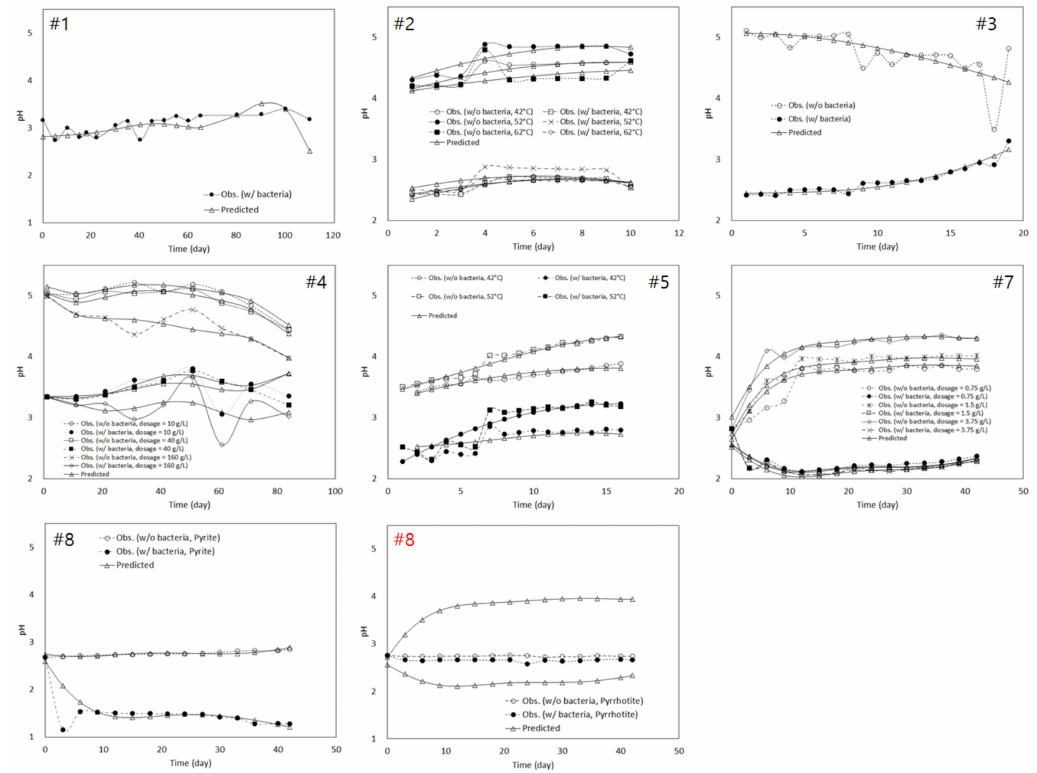
Figure 3. Observed and ANN-predicted pH changes with a topology of 9:15:1. The numbers are from Table 1, while red number is the result from the data for further verification.